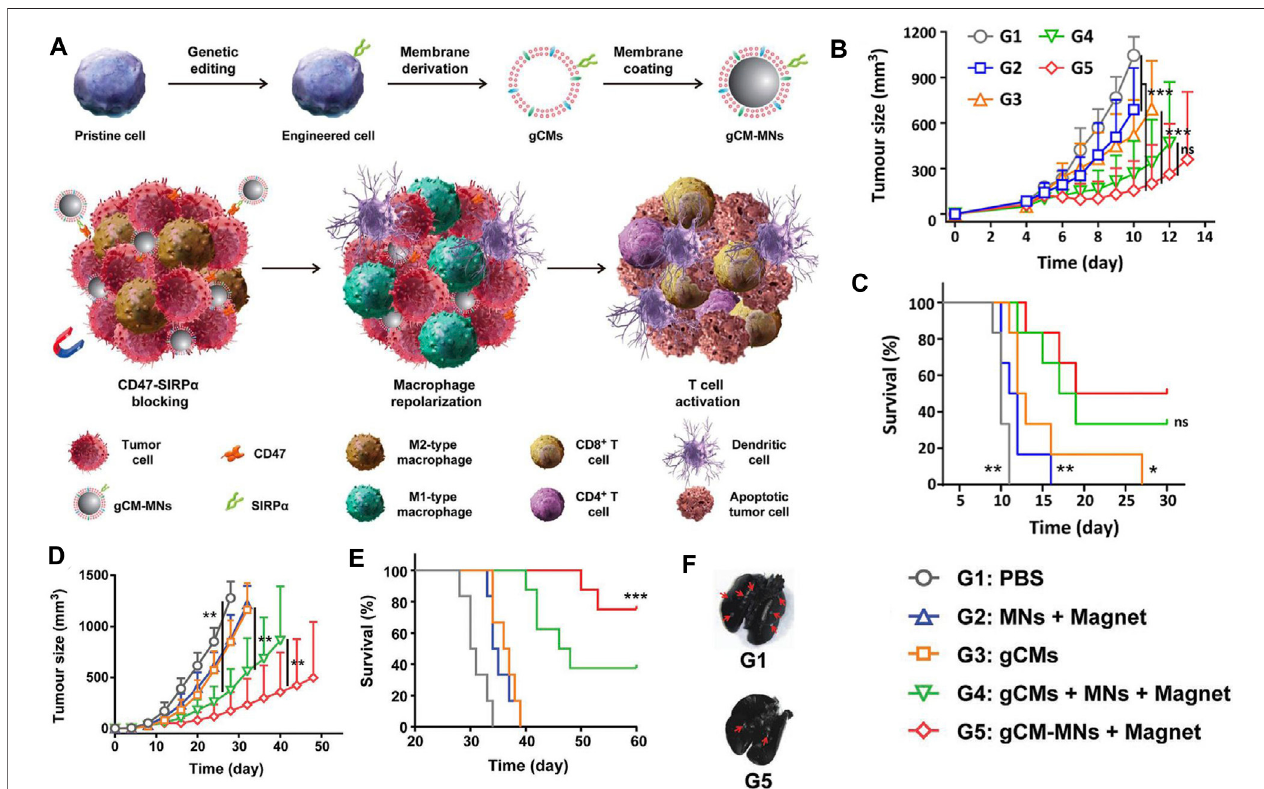
FIGURE3 |(A) Scheme ofgenetically edited cell-membrane-coated magnetic nanoparticles (gCM-MNs)elicitspotent macrophageimmuneresponses for cancer immunotherapy. (B,C) gCM-MNs inhibit B16F10 tumor growth. (B) Tumor growth kinetics after indicated treatments. (C) Survival curves for different treatment groups. (D – F) gCM-MNs suppress 4T1 tumor growth and lung metastasis. (D) Average tumor growth kinetics after indicated treatments. (E) Survival curves for different treatment groups. (F) Ink-stained lung photographs for different treatment groups. The red arrowheads indicate tumor foci in the lung. Adapted with